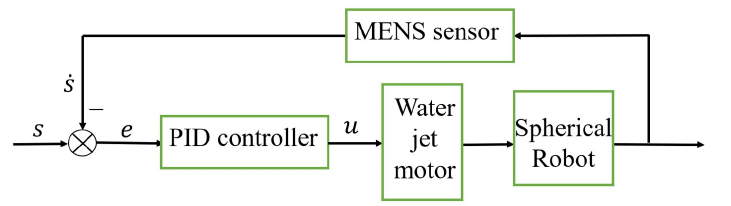
Figure 3. The block diagram of the heading angle control during a single robot motion.